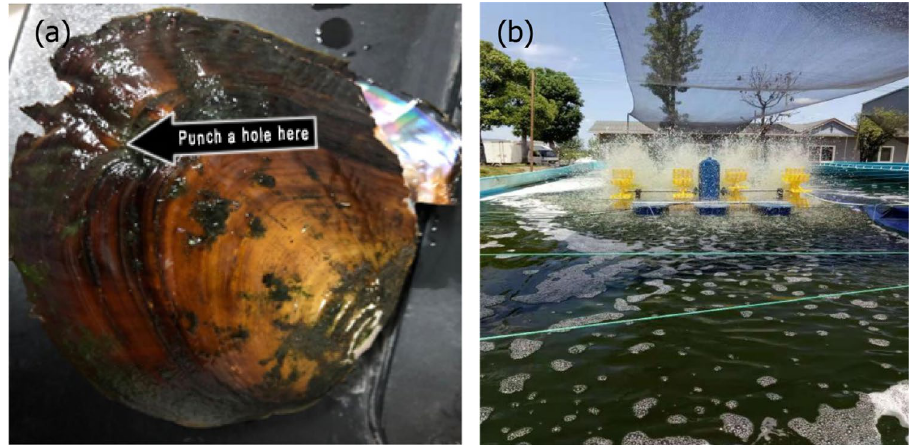
Figure 1. ( a ) Adult mussel used in the study, ( b ) large-scale cultivation of microalgae in a